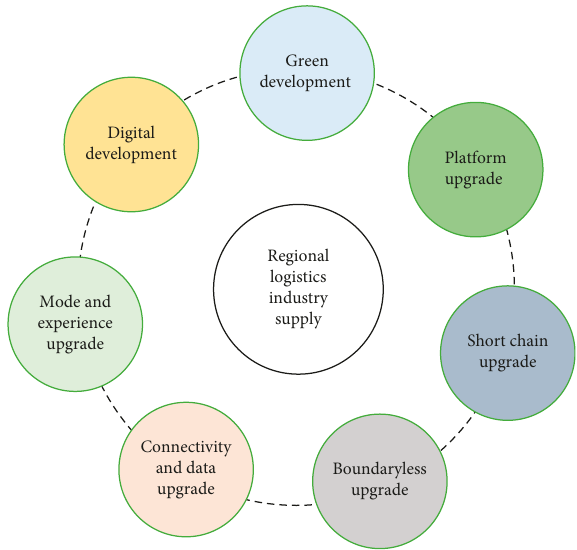
Figure 4: Circular wireframe of regional logistics supply chain- oriented development